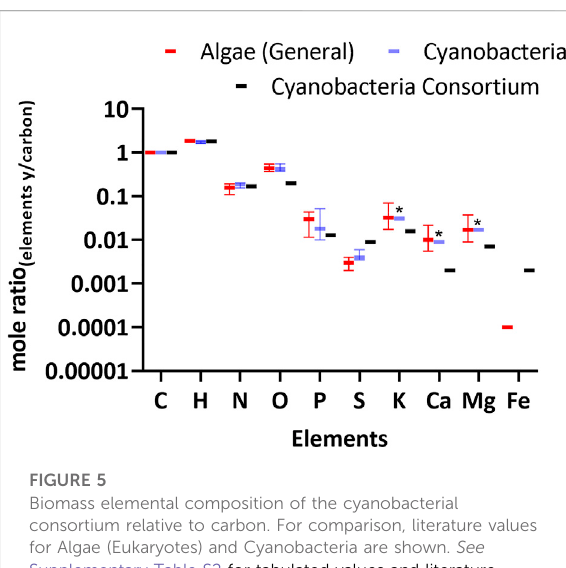
FIGURE 5 Biomass elemental composition of the cyanobacterial consortium relative to carbon. For comparison, literature values for Algae (Eukaryotes) and Cyanobacteria are shown. See Supplementary Table S2 for tabulated values and literature references. Error bars represent the interquartile range and solid lines represent themedian. Asterisk represents the elements in the literature where only a single data point was collected for M.